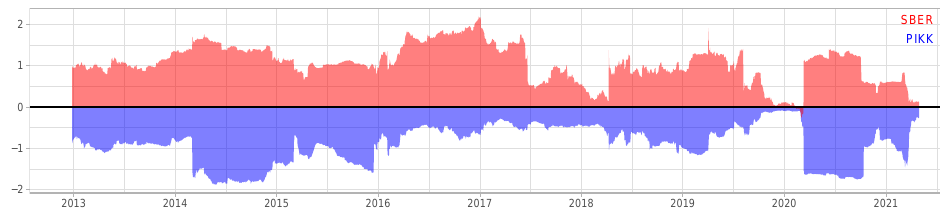
Figure 7. Net volatility spillover for SBER and